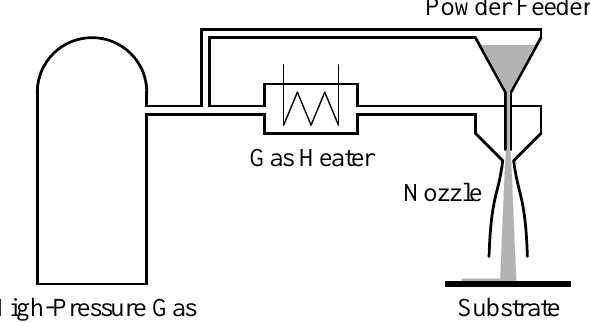
Figure 1. Set-up of the Cold Spray